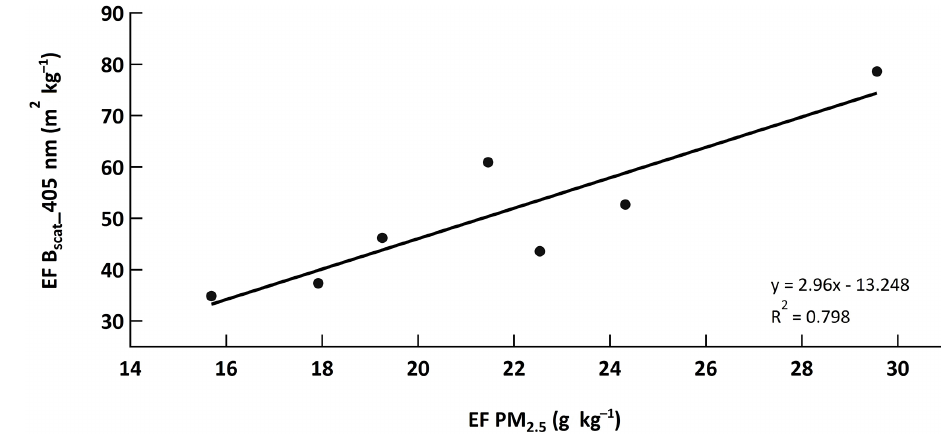
Figure 5. The emission factor of B scat at 405nm vs. PM 2 . 5 EF. The slope is an estimate of the mass-scattering